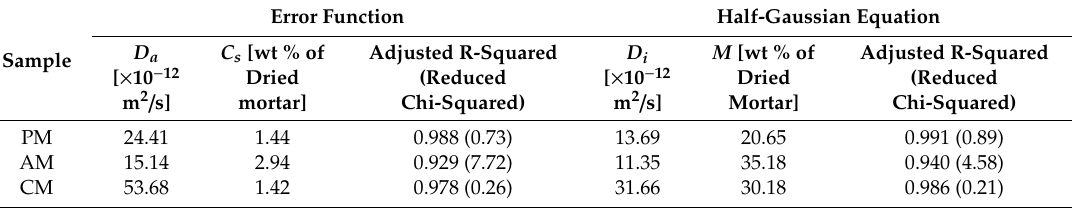
Table 7. Computed parameters of error function and half-Gaussian equation in the natural chloride diffusion test.